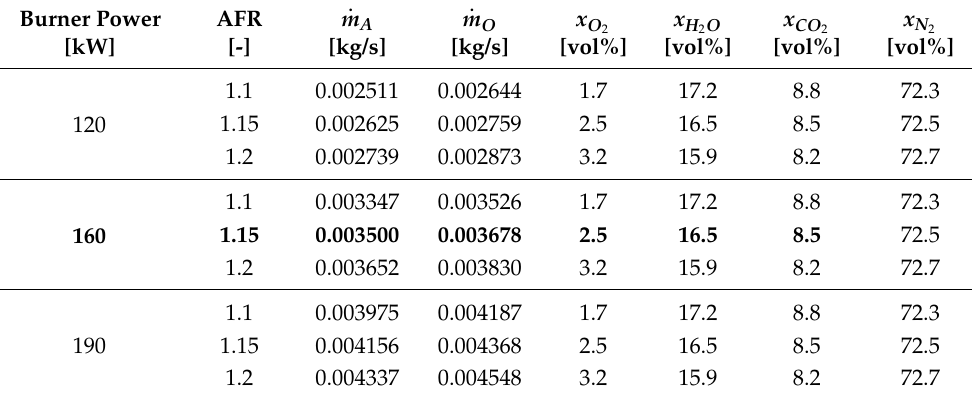
Table 2. Boundary conditions for several burner power and air–fuel ratio values.